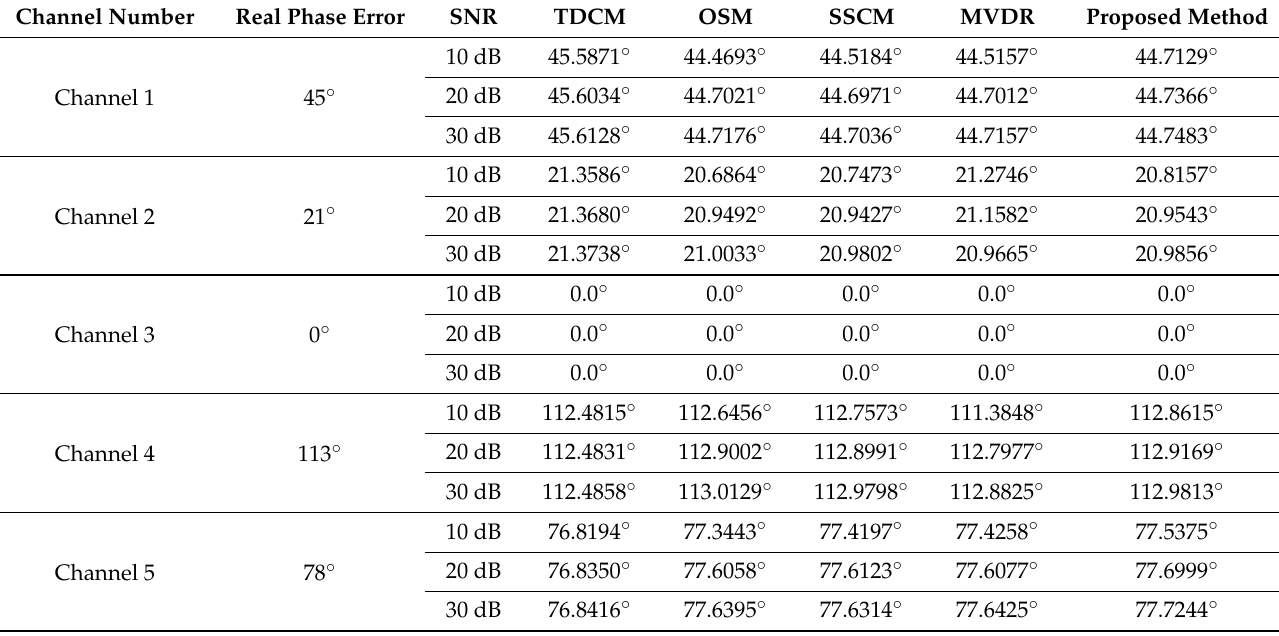
Table 2. Estimation results of conventional methods and proposed method with different SNRs. Channel